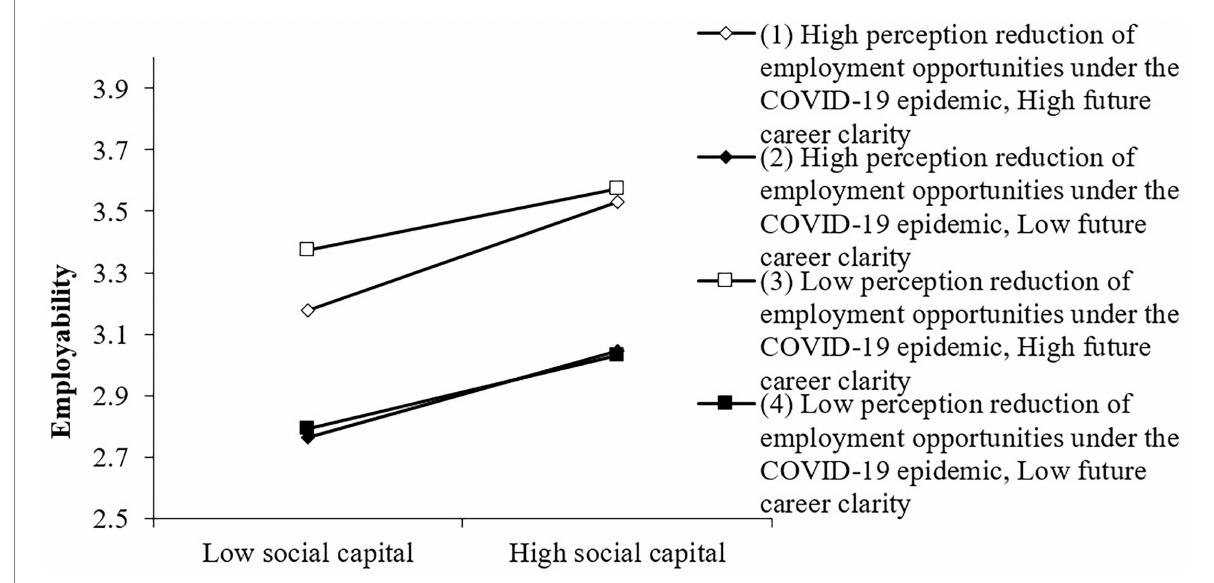
FIGURE 5 The joint adjustment effect of perception reduction of employment Opportunities under the COVID-19 epidemic and future career clarity on social capital and